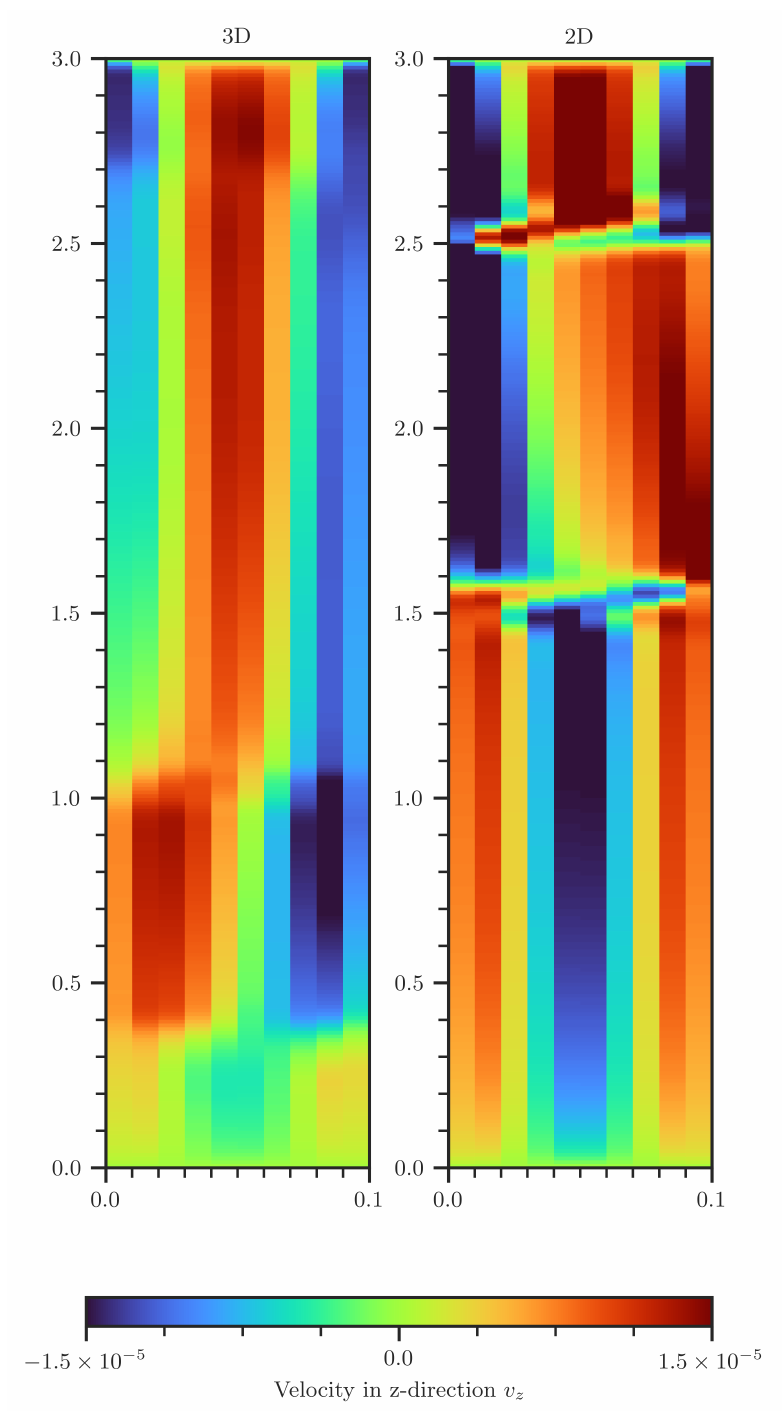
Figure A7. Comparison of vertical velocity in the 2D ( right ) and 3D ( left ) scenario. In 3D, the velocities are volume averaged over the second spatial